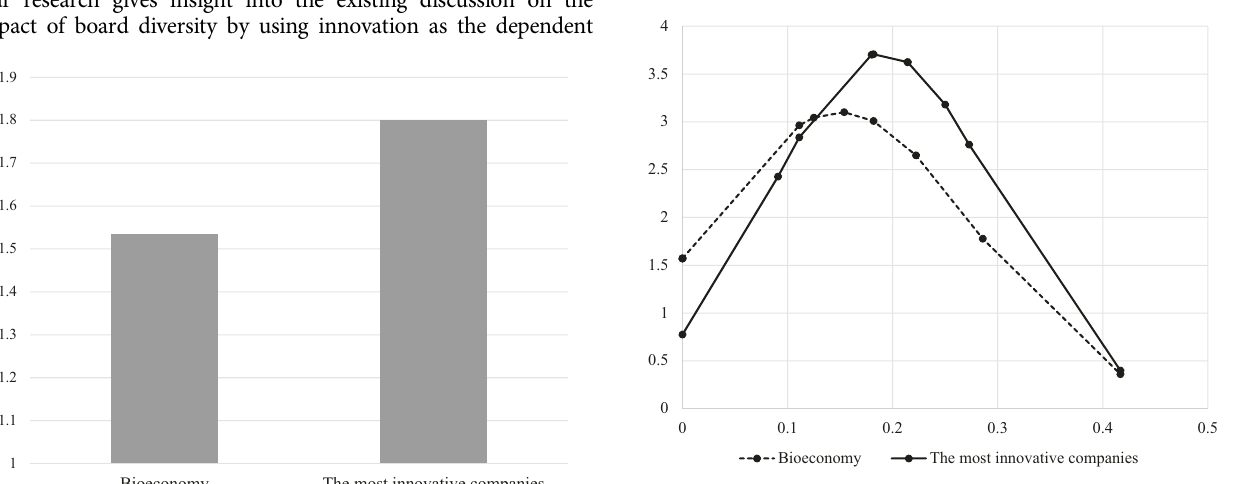
Fig. 3 Normal distribution of the ethnic diversity in the bioeconomy and the most innovative companies. Ethnic diversity in bioeconomy (dotted line) versus the most innovative companies (solid line). Data shows more disperse ethnic diversity for bioeconomy companies and more bioeconomy companies having boards with no ethnic diversity.